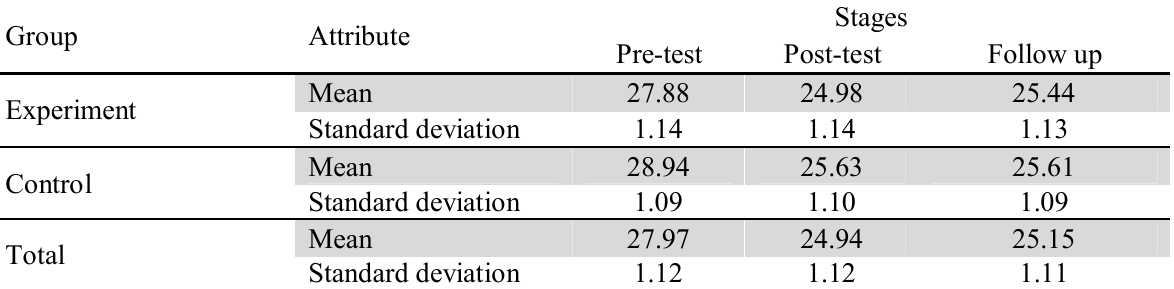
The summary of mean and standard deviation of scores given to experiment and control groups